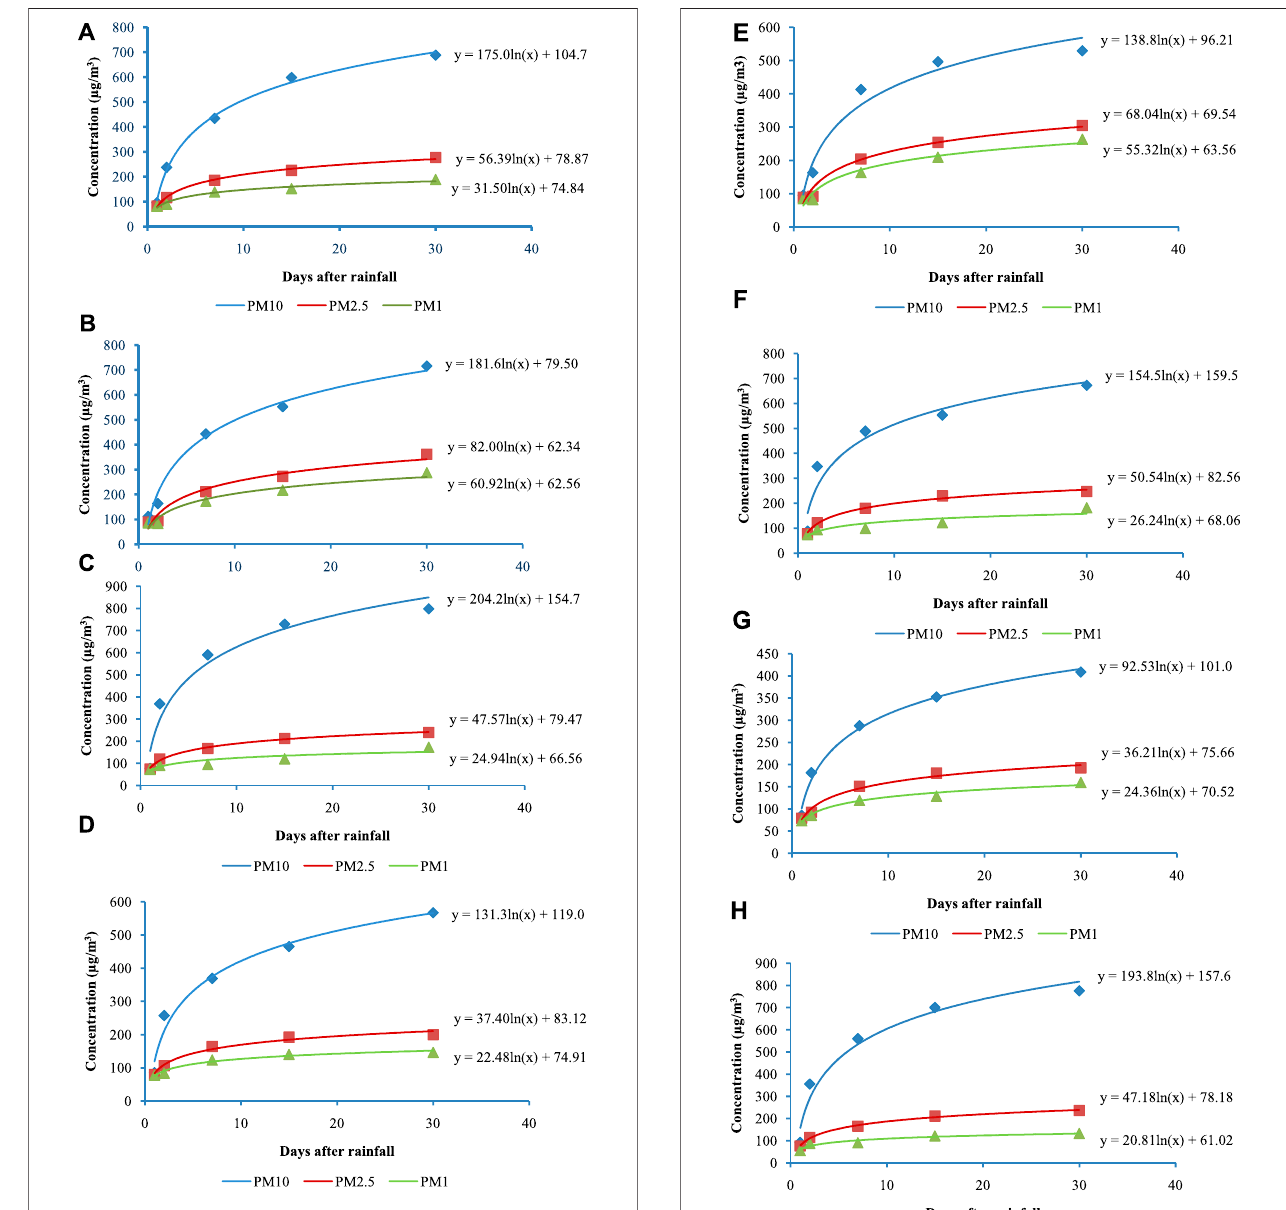
FIGURE 4 | Concentration buildup of PM10, PM2.5, and PM1 after rainfall at different sites in Dhanbad road networks [ (A) BM, (B) SC, (C) STN, (D) CC, (E) RVC, (F) HP, (G) ISM, (H) SG, (I) BB, and (J)